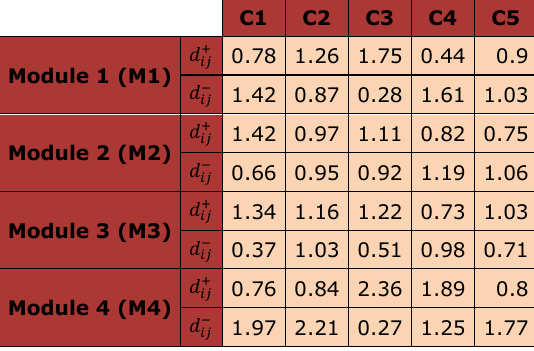
Table 5. The weighted Euclidian distance from and